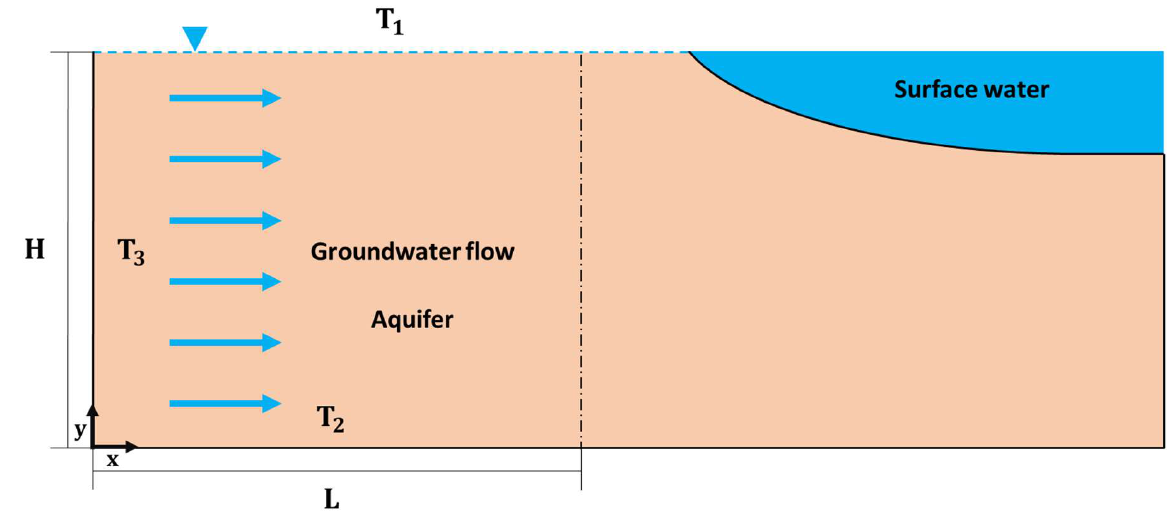
Figure 1. Physical scheme of the problem and boundary conditions.